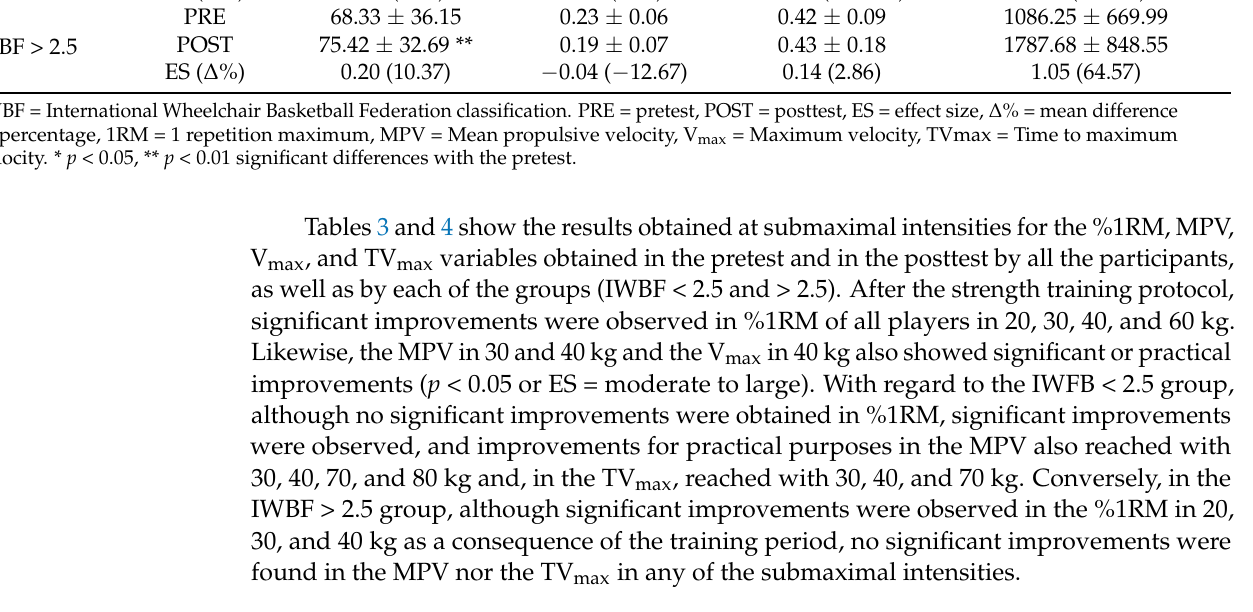
Table 3. Results obtained in both the pretest and the posttest at submaximal intensities of 1RM (%1RM and MPV) by all the participants, the IWBF < 2.5 group, and the IWBF > 2.5